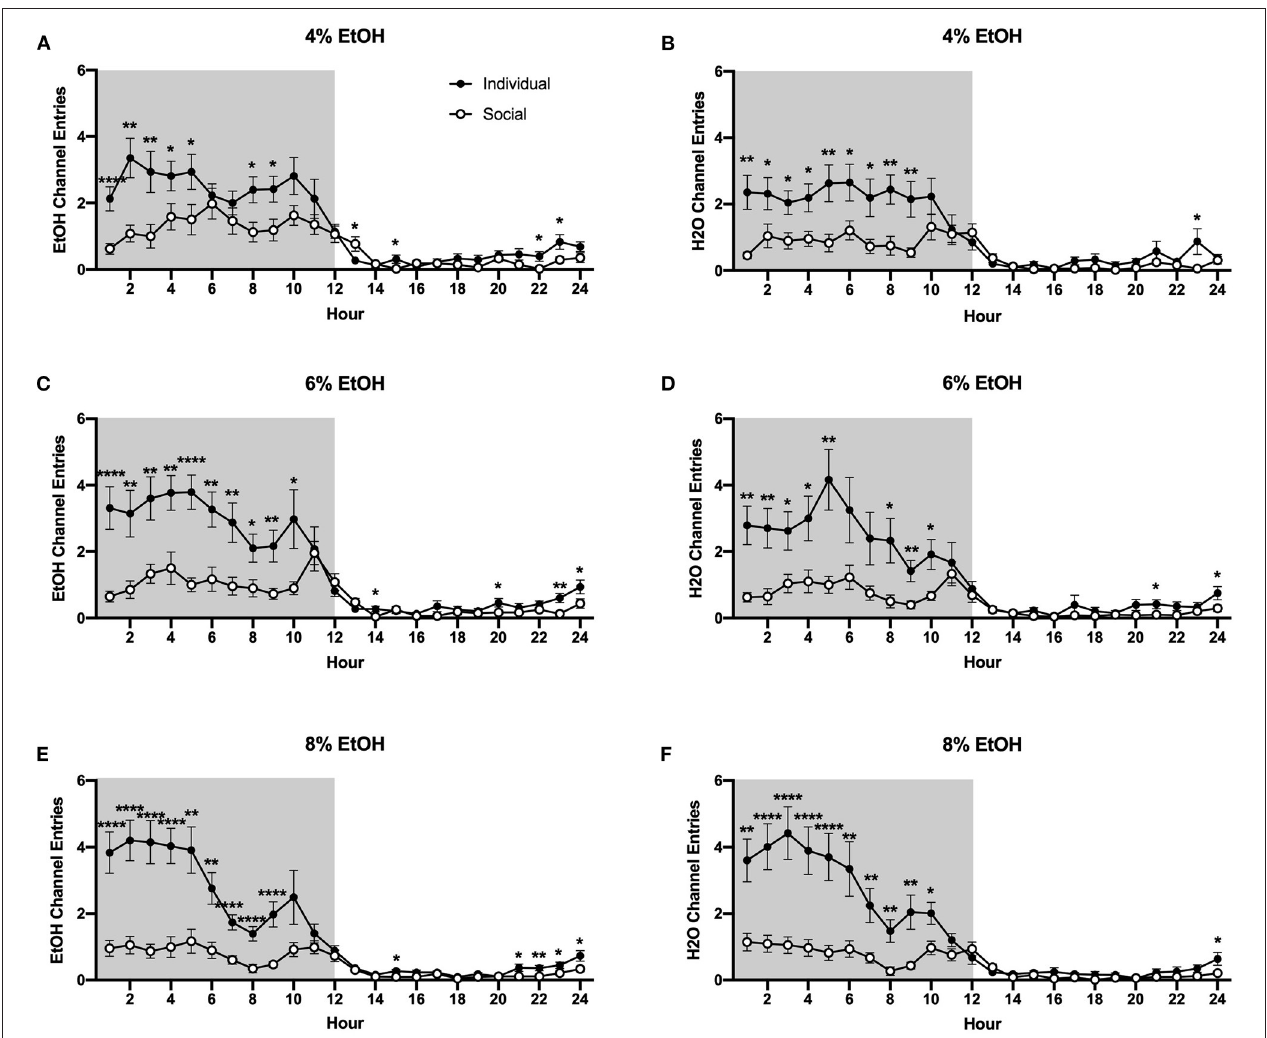
FIGURE 6 | Hourly baseline channel entries. (A) Ethanol and (B) water channel entries when 4% ethanol was available. (C) Ethanol and (D) water channel entries when 6% ethanol was available. (E) Ethanol and (F) water channel entries when 8% ethanol was available. For both ethanol and water channels, and across all ethanol concentrations presented, individually-housed mice made significantly more non-consummatory channel entries than socially-housed mice. * p < 0.05, ** p < 0.01, **** p < 0.0001, compared to opposite housing condition. Data represented as mean ± SEM. n = 24/group. Shaded regions are representative of the dark